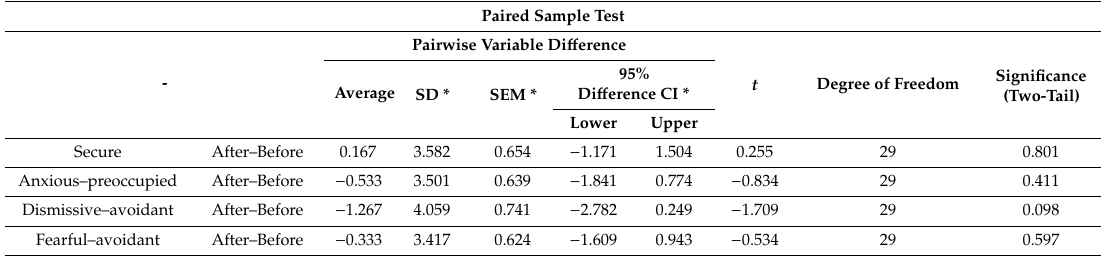
Table 7. Pre- and post-tests for di ff erences in detection of attachment style.